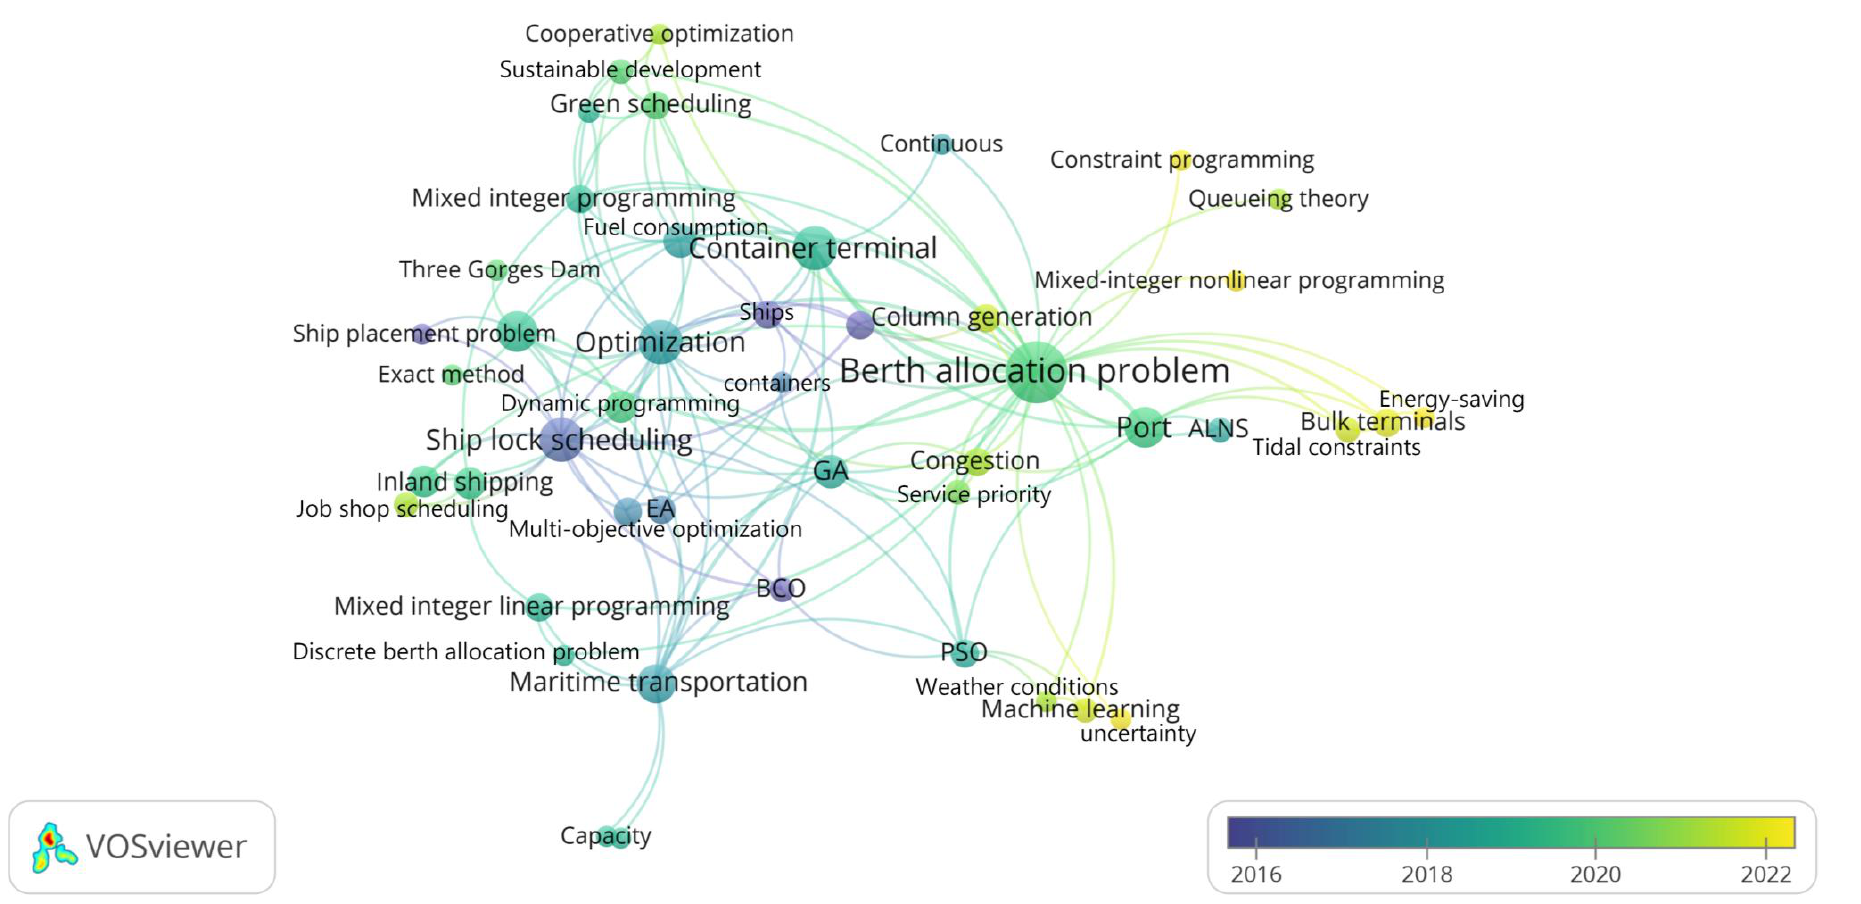
Figure 2. Word cloud of keywords.